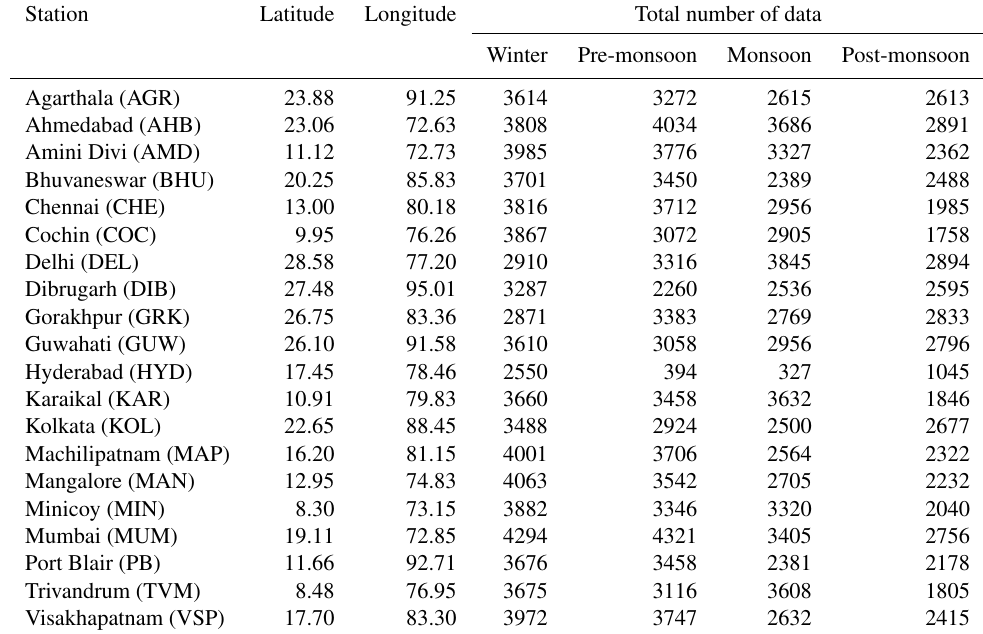
Table 1. The total number of data available during four seasons for the 20 stations for the period from April 2014 to March 2017.